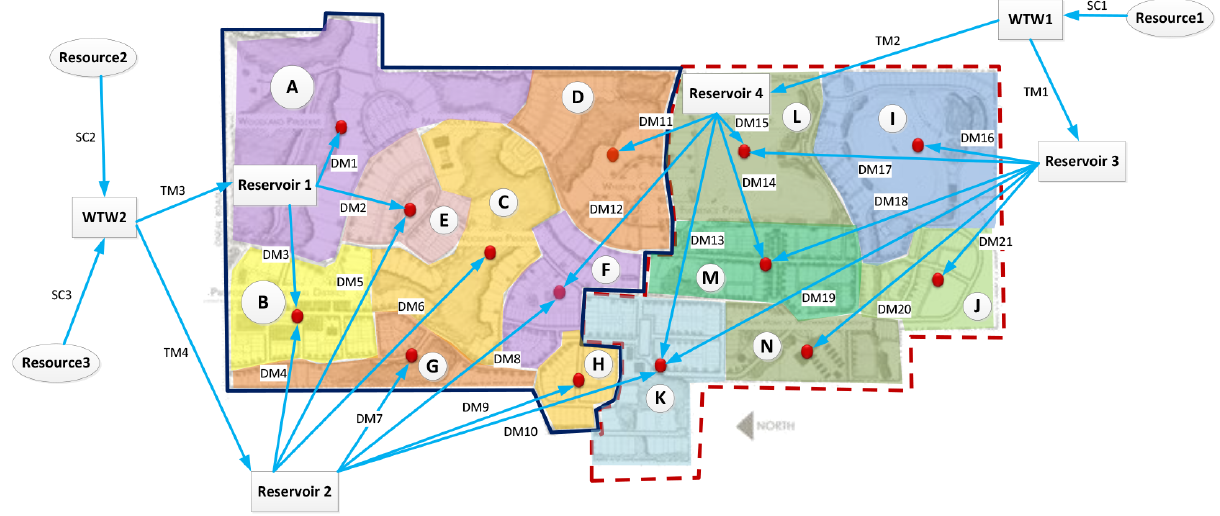
Figure 1. A schematic example of a water supply system representation in WaterMet 2 ; SC=water supply conduit; TM=trunk main; DM=distribution main; WTW=water treatment